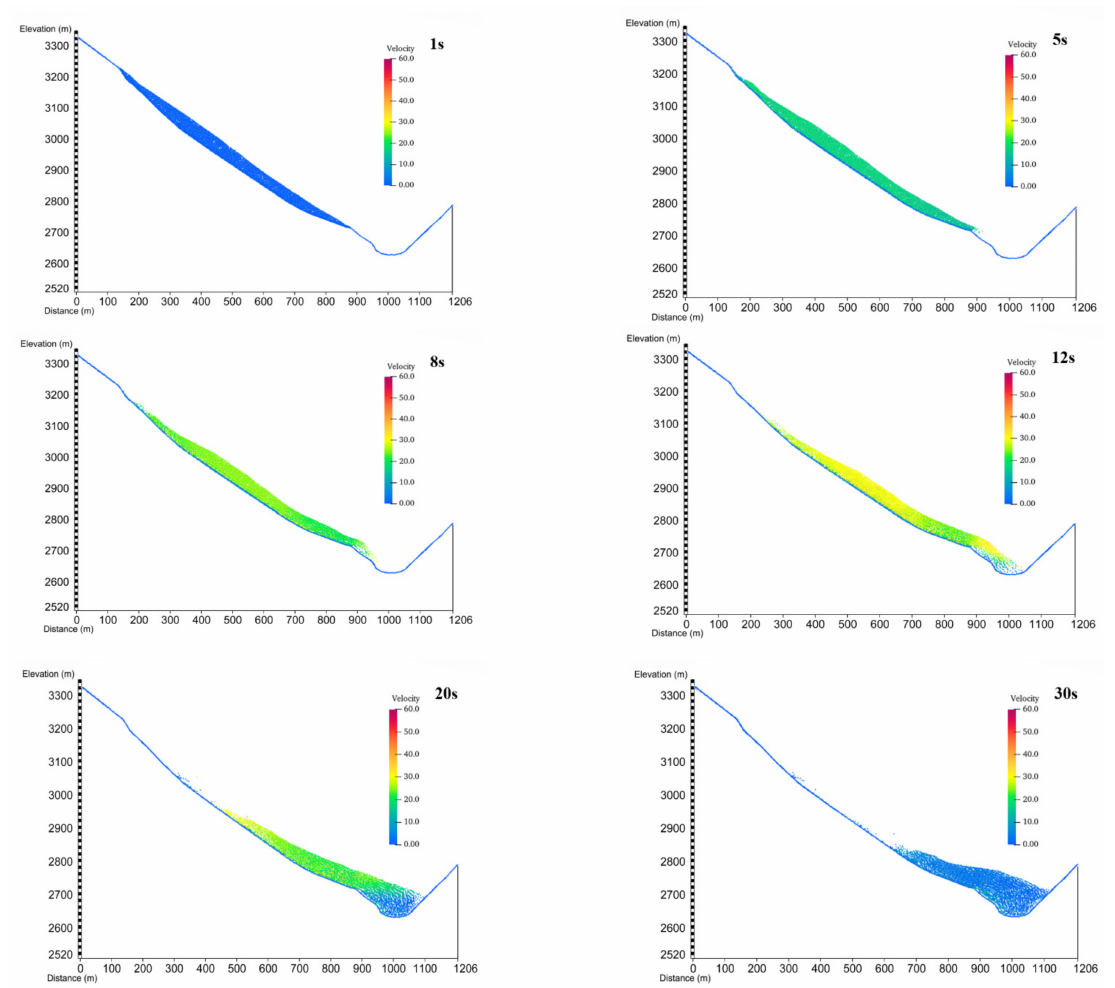
Figure 11. Cloud map of sliding velocity distribution in the accumulation layer at different times (1, 5, 8, 12, 20, and 30 s) during a